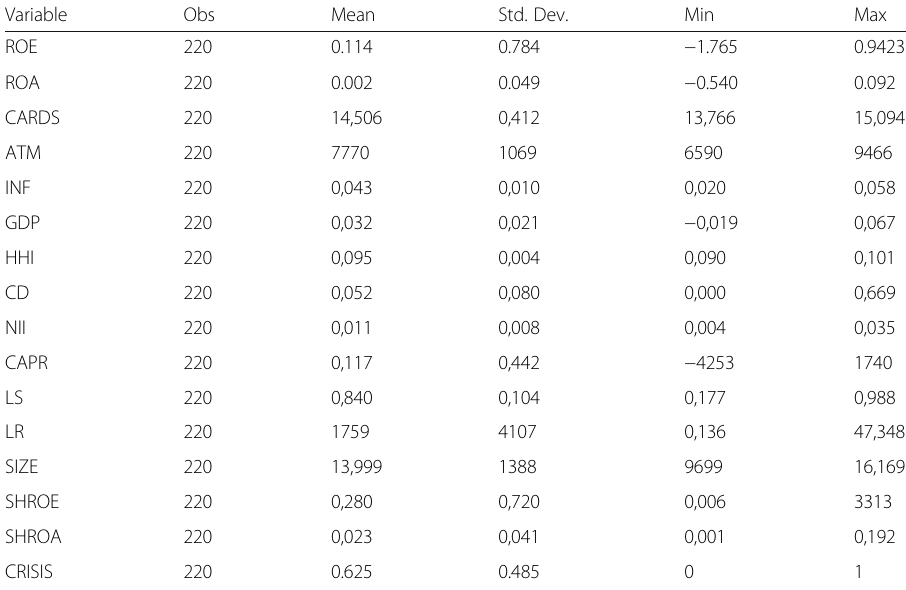
Table 3 Summary